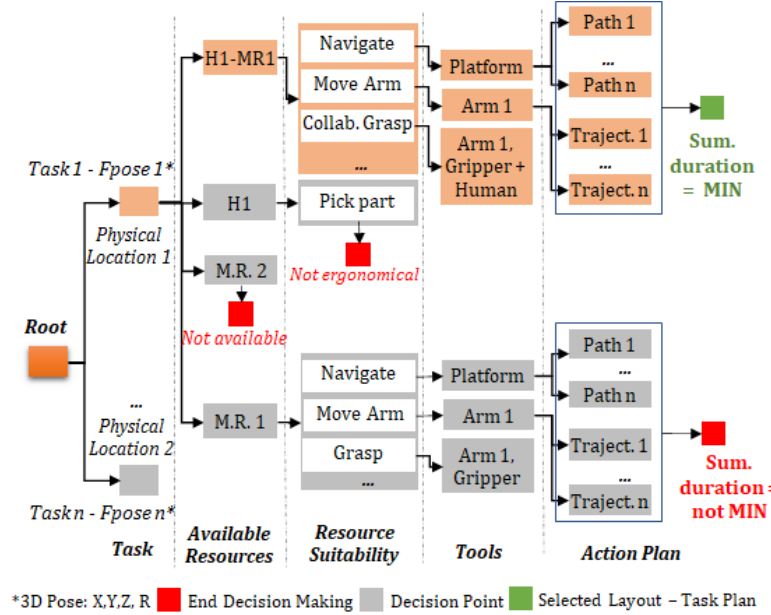
Figure 5. Decision-making logic for reconfigurable factories.